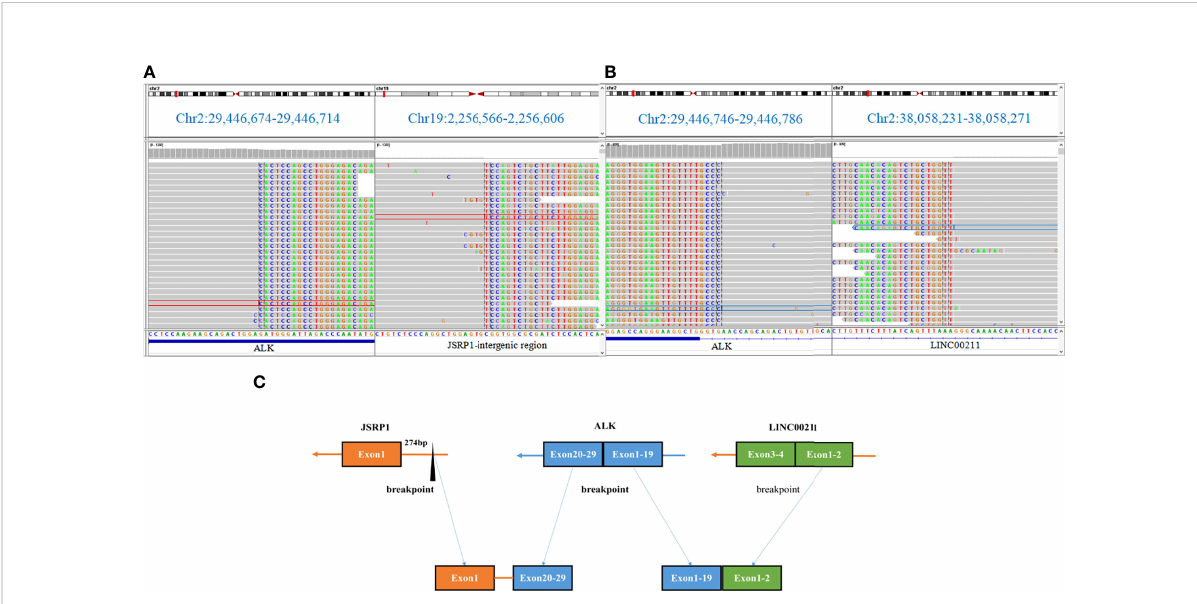
FIGURE 3 DNA-based next-generation sequencing fi ndings for paraf fi n-embedded specimen of the patient. (A, B) The novel non-reciprocal JSRP1-ALK (Jintergenic:A20) rearrangement visualized using the Integrative Genomics Viewer. (C) Diagram depicting the non-reciprocal ALK fusion.